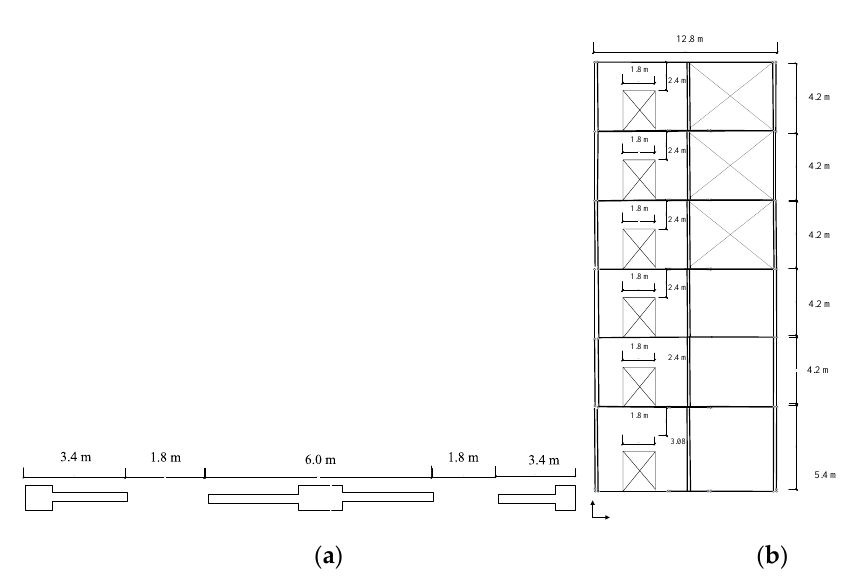
Figure 10. The coupled shear wall and implementation of MRLs ( a ) Top view ( b ) Plan view.